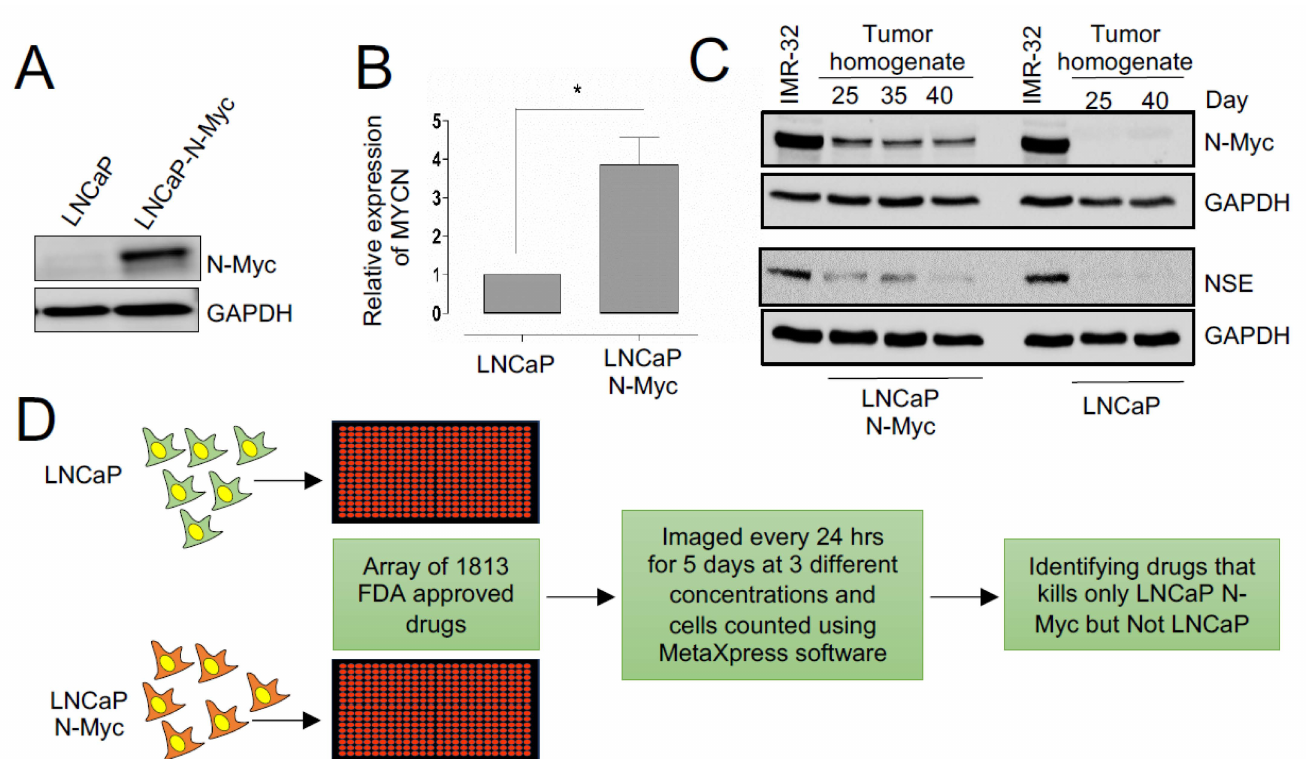
Figure 1. Identifying drugs with differential effects on the fitness of N-Myc overexpressing LNCaP cells. ( A ) Western blot showing N-MYC protein levels in the indicated isogenic cell lines. GAPDH is used as a loading control. ( B ) Expression levels of MYCN tested by RT-PCR in the isogenic cell lines ( p < 0.05). ( C ) Western blots of LN-P and LN-Myc tumor homogenates at the indicated time points post cell implantation. Levels of N-MYC and NSE were assessed. ( D ) Schematic representing the pipeline of the high-throughput drug library screening in isogenic models. An array of FDA-approved drug libraries was used to identify those compounds that inhibit the growth of LNCaP-N-Myc but not the LNCaP cells. * p <